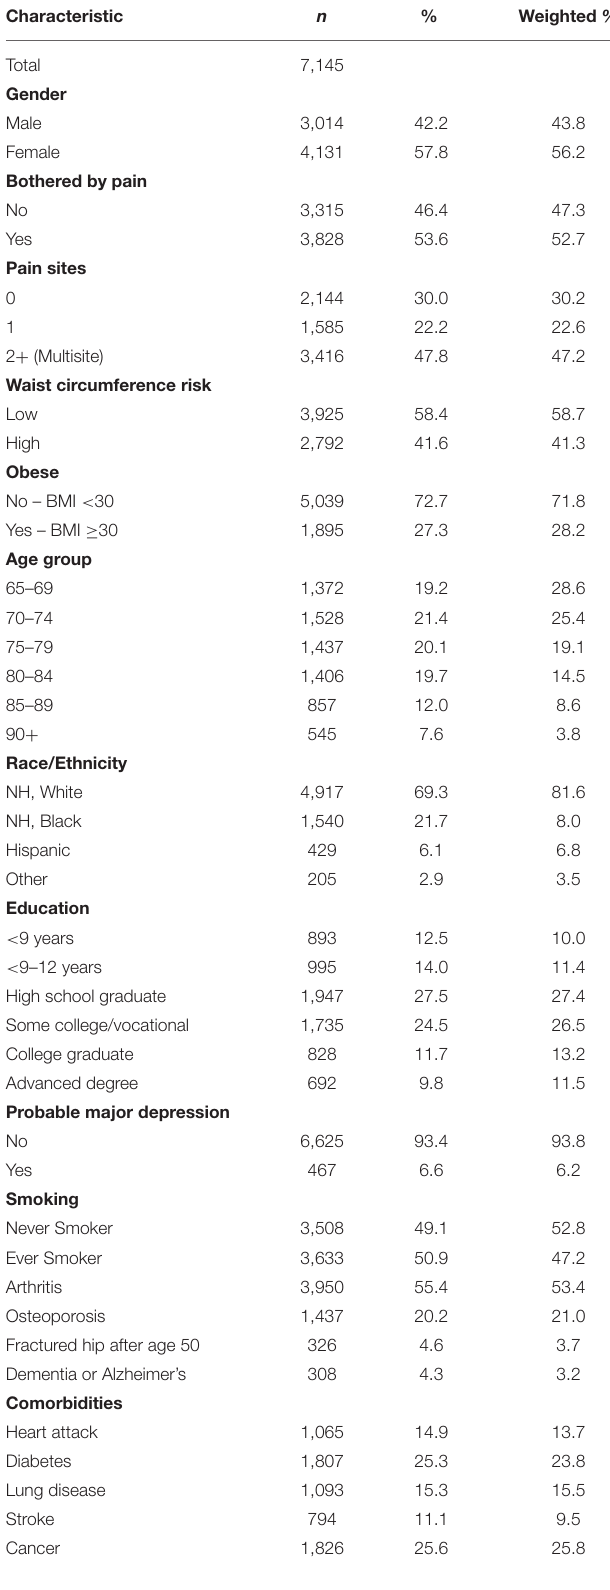
TABLE 1 | 2011 baseline characteristics of national health and aging trends study participants, for study of central adiposity and pain.